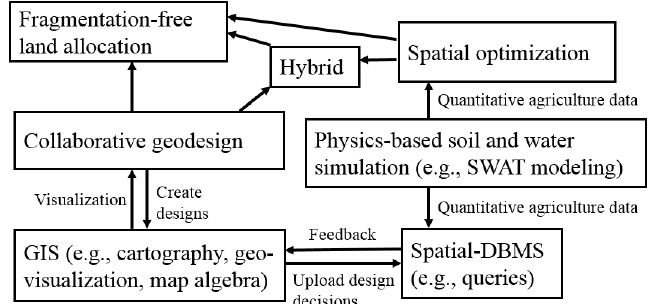
Figure 4. Overall architecture of fragmentation-free land allocation. SWAT: Soil and Water Assessment Tool. GIS: Geographic Information System. DBMS: Database Management System.